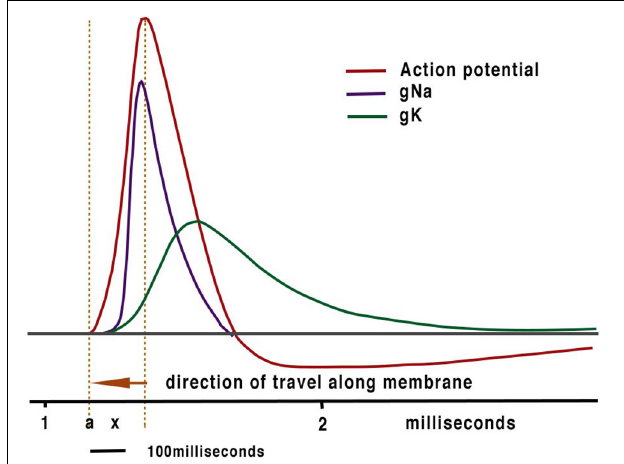
FIGURE 1 | The conventional textbook action potential showing the sodium and potassium currents with which it is